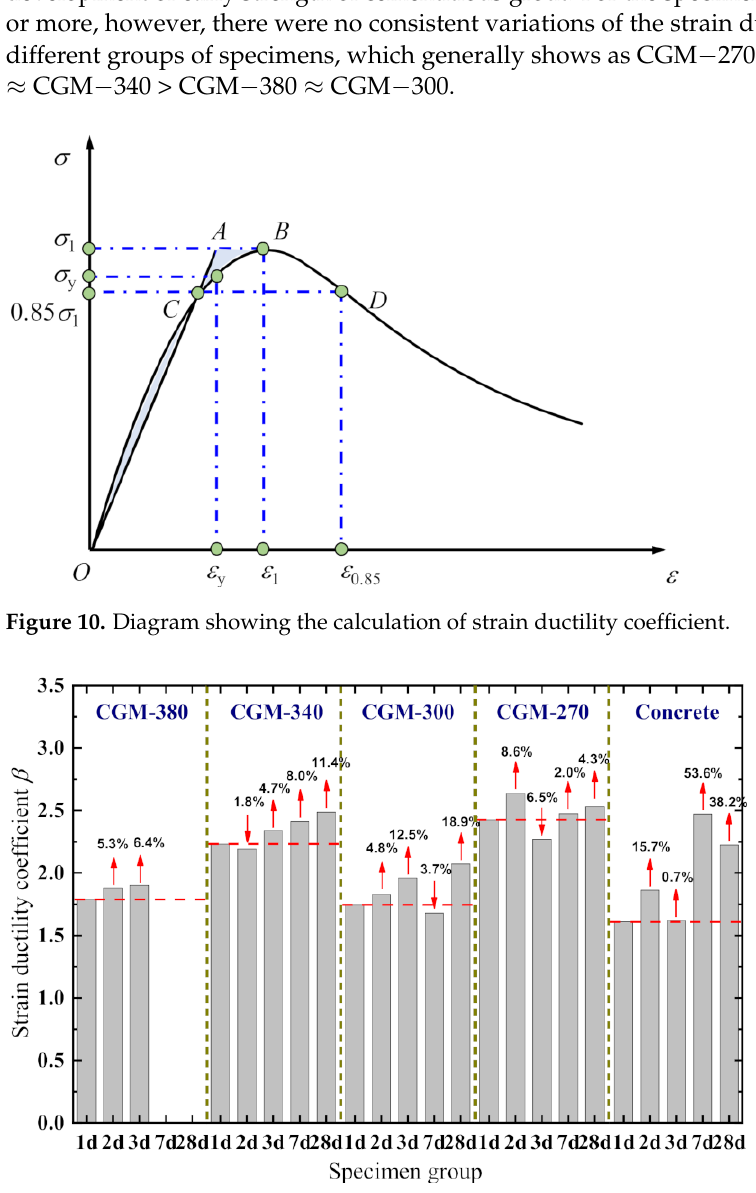
Figure 11. Strain ductility coefficient of